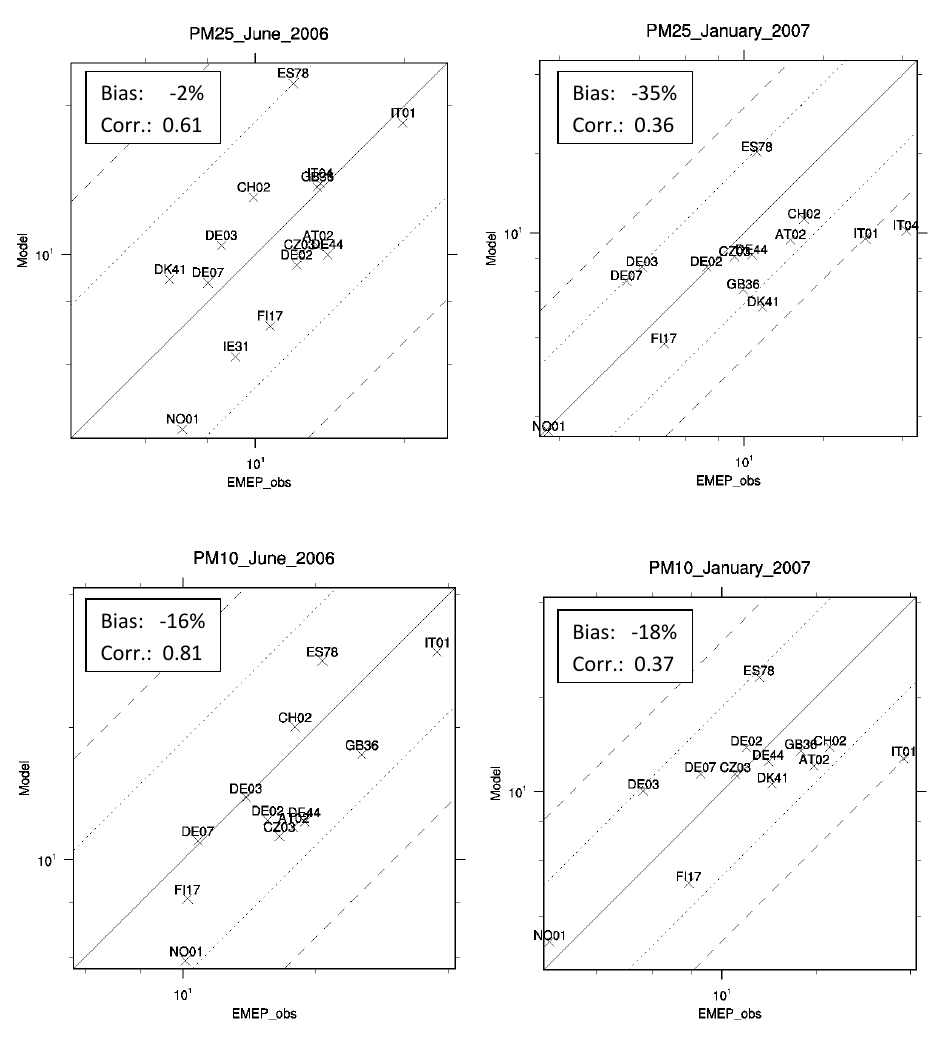
Fig. 4. Scattered plot of model and measured PM 1 0 and PM 2 . 5 mass during the EMEP intensive measurement